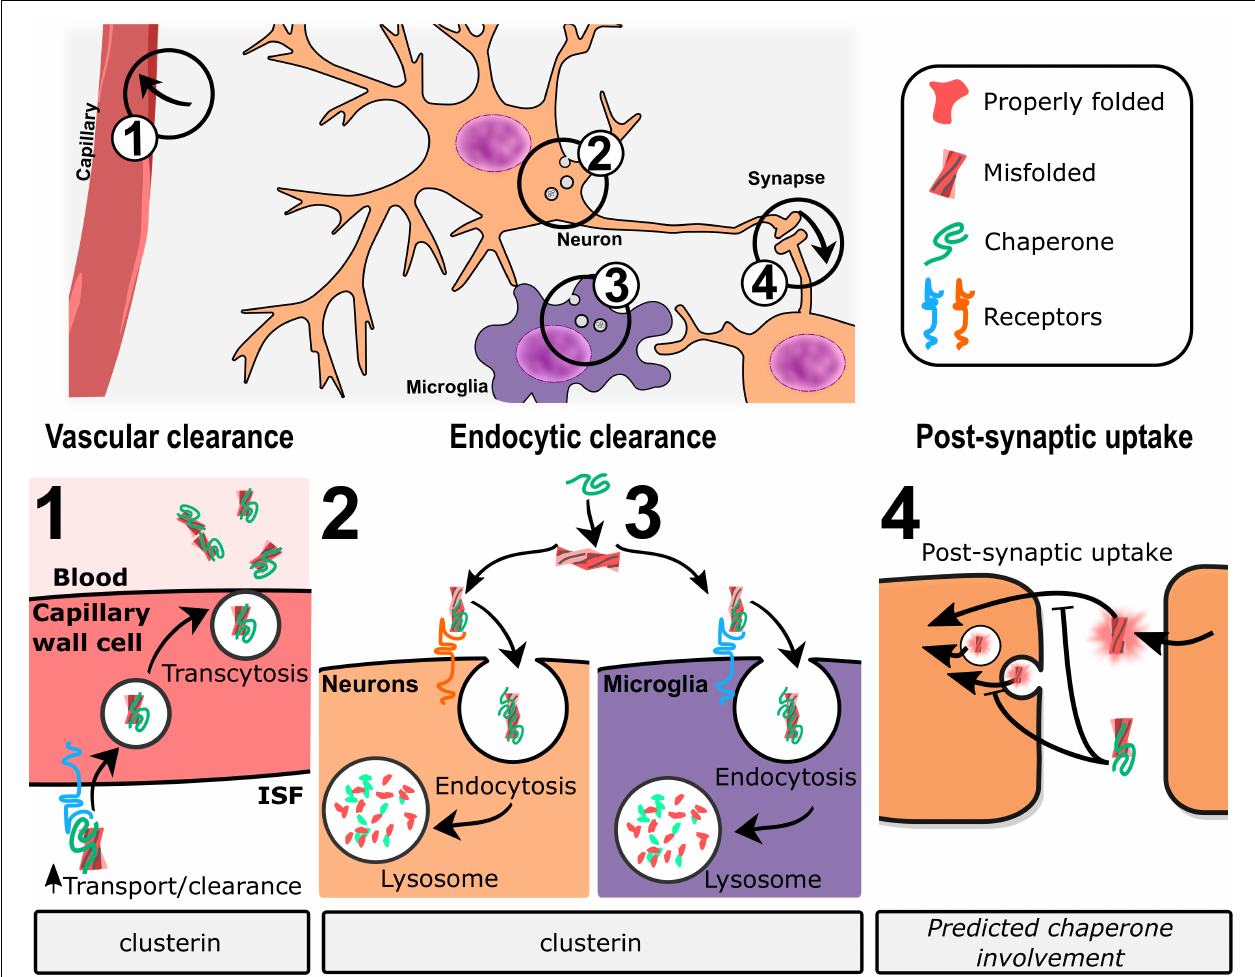
FIGURE 2 | Potential mechanisms for extracellular chaperone action in neurodegenerative disease: Clearance and transmission. A schematic diagram of proposed mechanisms of action of extracellular chaperones activity on transmission and clearance of misfolded and aggregating substrates. (1) Vascular clearance. Chaperone–client complexes are recognized by cell surface receptors on the capillary endothelium for transcytosis from the interstitial fluid (ISF) to the blood for removal. Chaperones that promote clearance across the blood–brain barrier are listed in the gray box. Endocytic clearance by (2) neurons or (3) microglia. Chaperone–client complexes interact with cell surface receptors on to promote the endocytosis and lysosomal degradation of chaperone–client complexes. Chaperones that show increased endocytosis and degradation of proteopathic seeds are listed in the gray box. (4) Post-synaptic uptake. Chaperones bind to secreted proteopathic seeds at the synapse to prevent their uptake (through either direct membrane penetration or endocytosis) by the post-synaptic neuron to reduce cell-to-cell transmission of disease pathology. (Note that no chaperone has yet been directly implicated in this